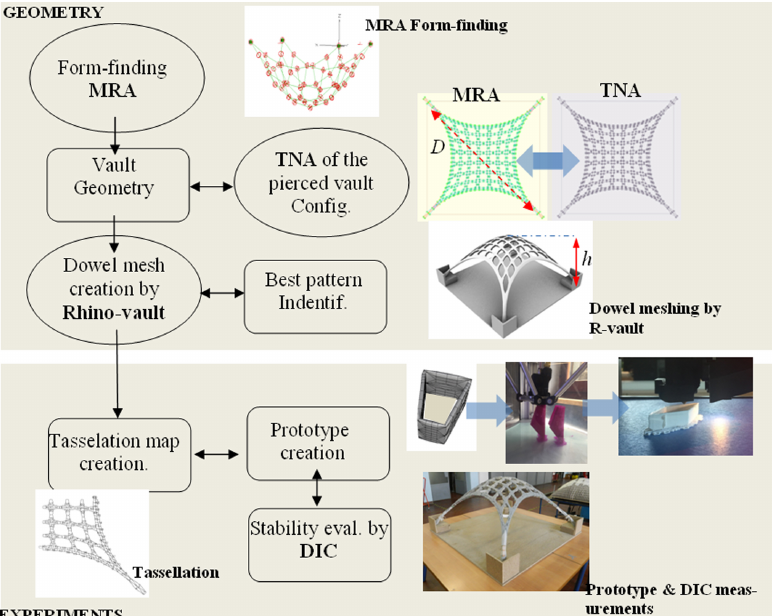
Figure 1: Flowchart of the Form-finding and the hole patterns definitions. The Form-finding is based on the MRA approach and is validated by the TNA. By the Rhino-vault application different patterns were considered and the tessellation map created. The scale model realized with a pierced area percentage of about 45% was analysed by DIC during loading